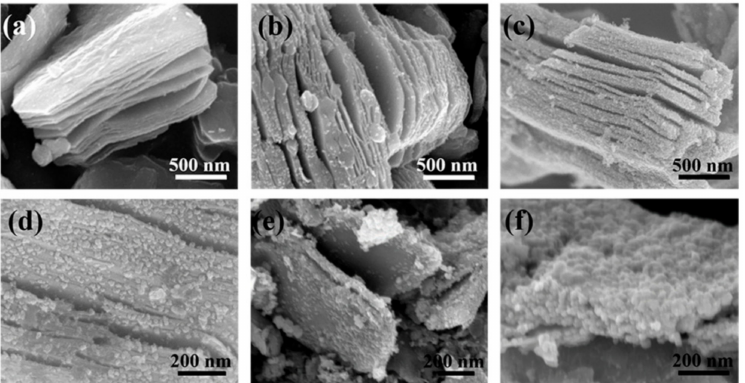
Figure 3. FESEM images of: ( a ) BTC, ( b ) BTTC-100, ( c , d ) BTTC-120, ( e ) BTTC-140, and ( f ) BTTC-160.